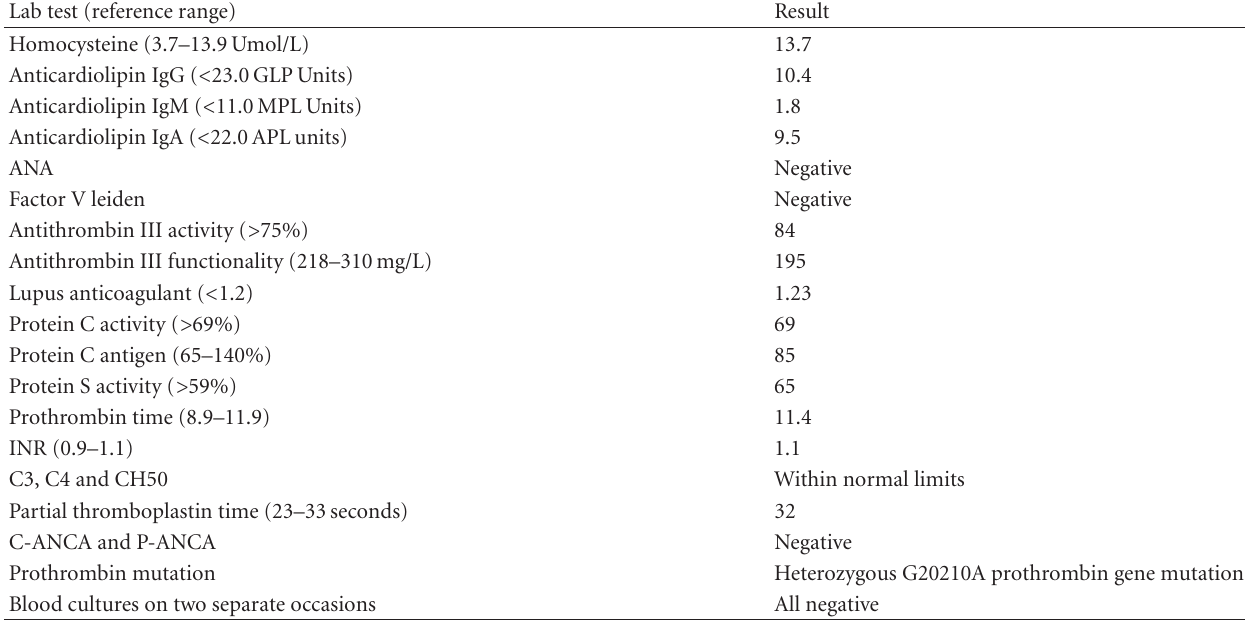
Table 1: Results of diagnostic